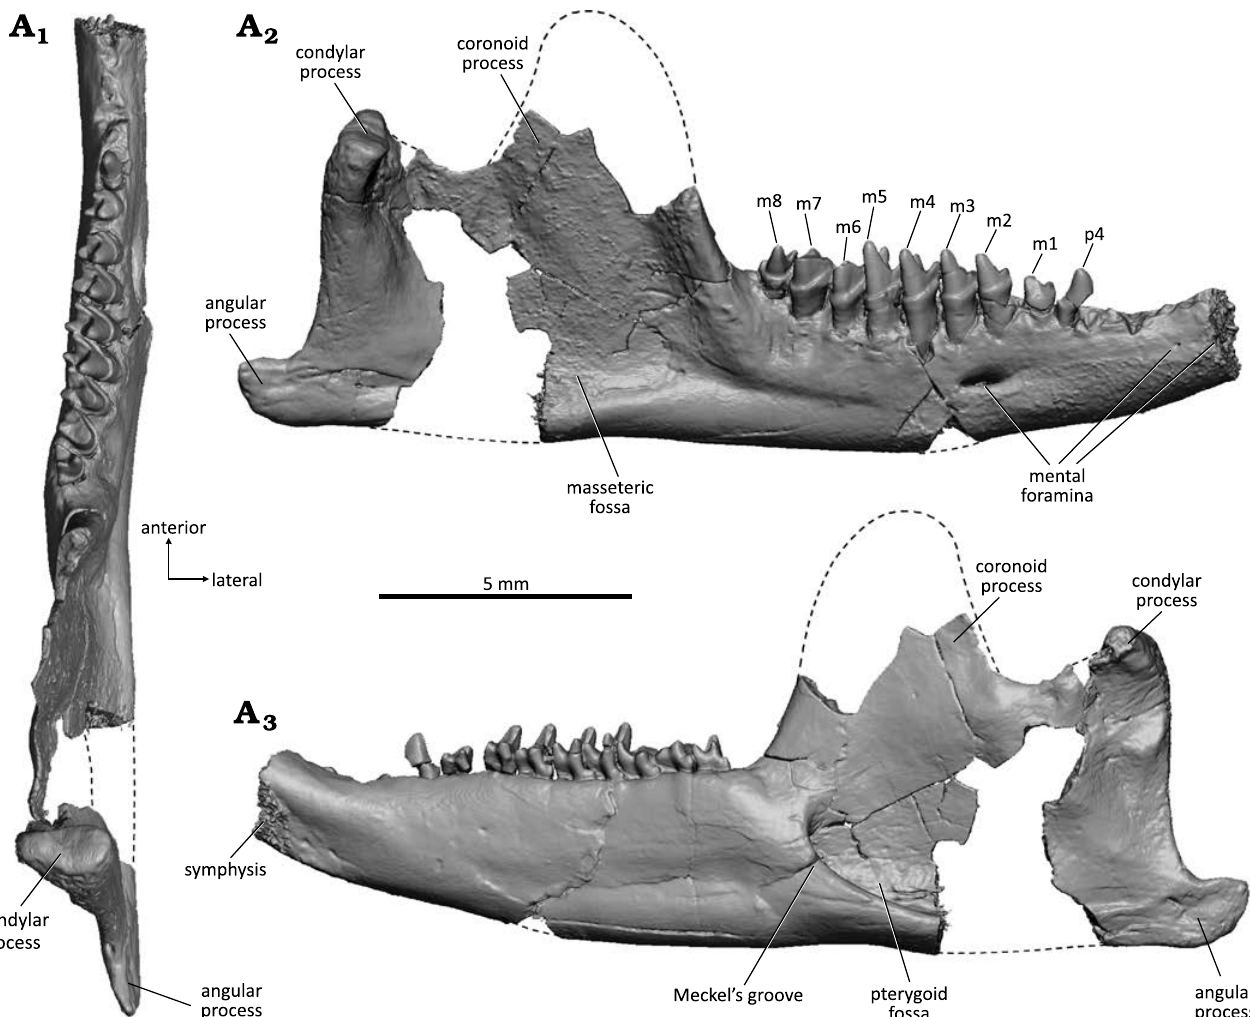
Fig. 12. Dryolestid mammal Crusafontia cuencana Henkel and Krebs, 1969, MfN Uña 2 (paratype) from Uña locality, province of Cuenca, Spain, Barremian (Lower Cretaceous). Right mandible in occlusal (A 1 ), lateral (A 2 ), and medial (A 3 ) views. Reconstruction of broken parts of coronid process, ventral border of mandibular body (preserved as mold in the embedding rock) and connection of articular condyle marked by stippled